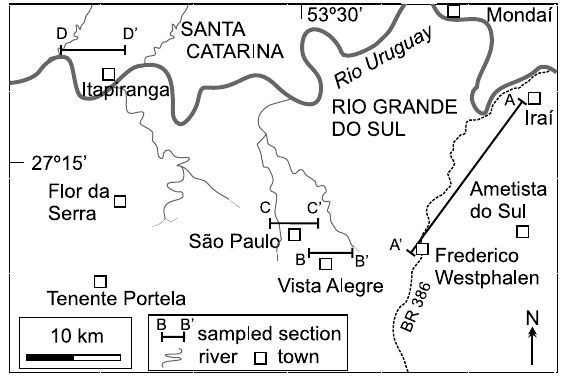
Fig. 2–LocationmapoftheVistaAlegreregion. Fourstudiedsections